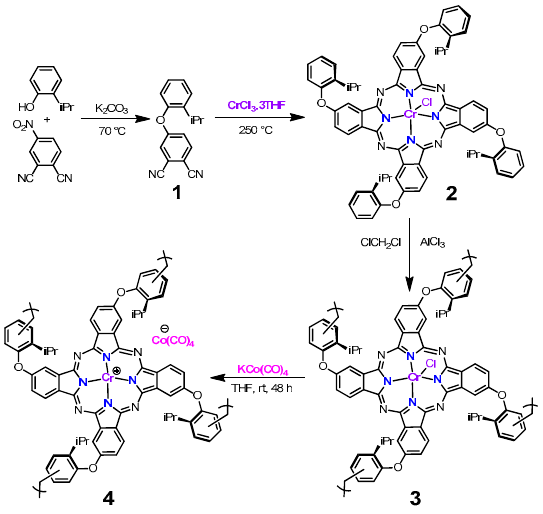
Figure 1. ( a ) SEM image of POP-Pc’CrCl, ( b ) TEM image of 3 , ( c ) N 2 sorption isotherms of 3 and 4 at 77 K, and ( d ) FTIR spectra of 2 , 3 , and 4